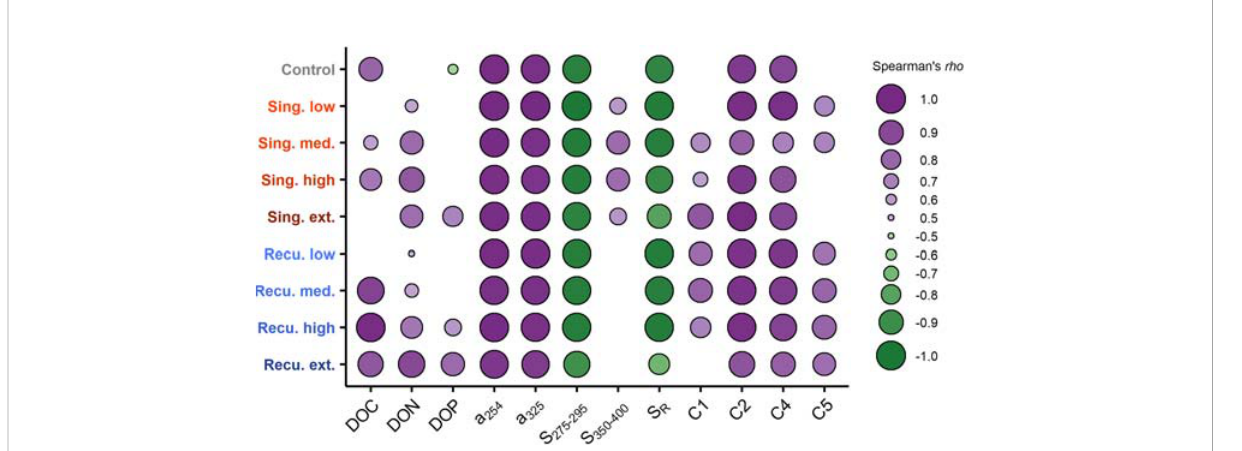
FIGURE 8 Relationship between cumulative prokaryotic heterotrophic production (PHP) and dissolved organic matter (DOM) parameters. Shown are Spearman ’ s rho ( r ) correlation coef fi cients per mesocosm. Only signi fi cant correlations (p < 0.05) are